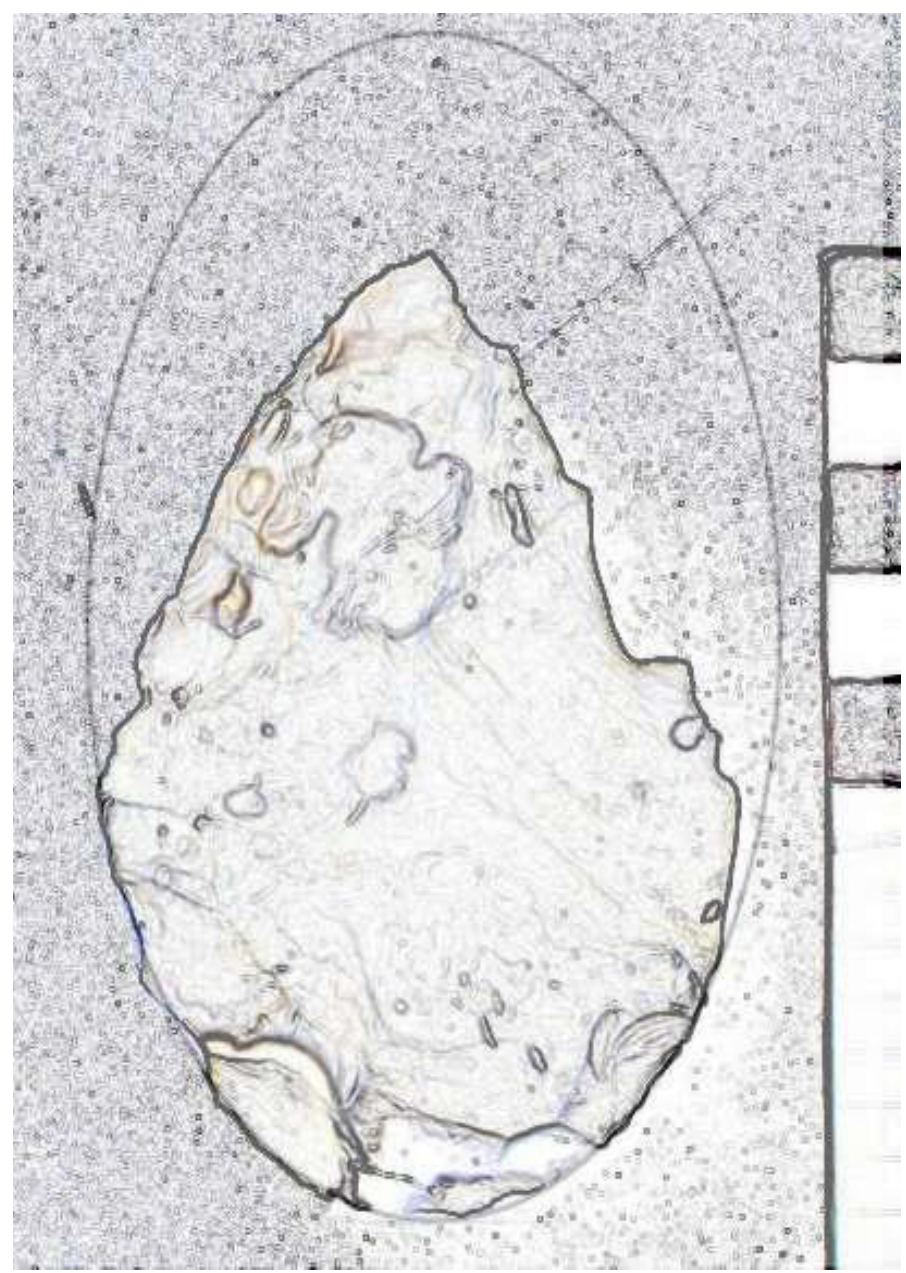
Figure 8. Specimen BO